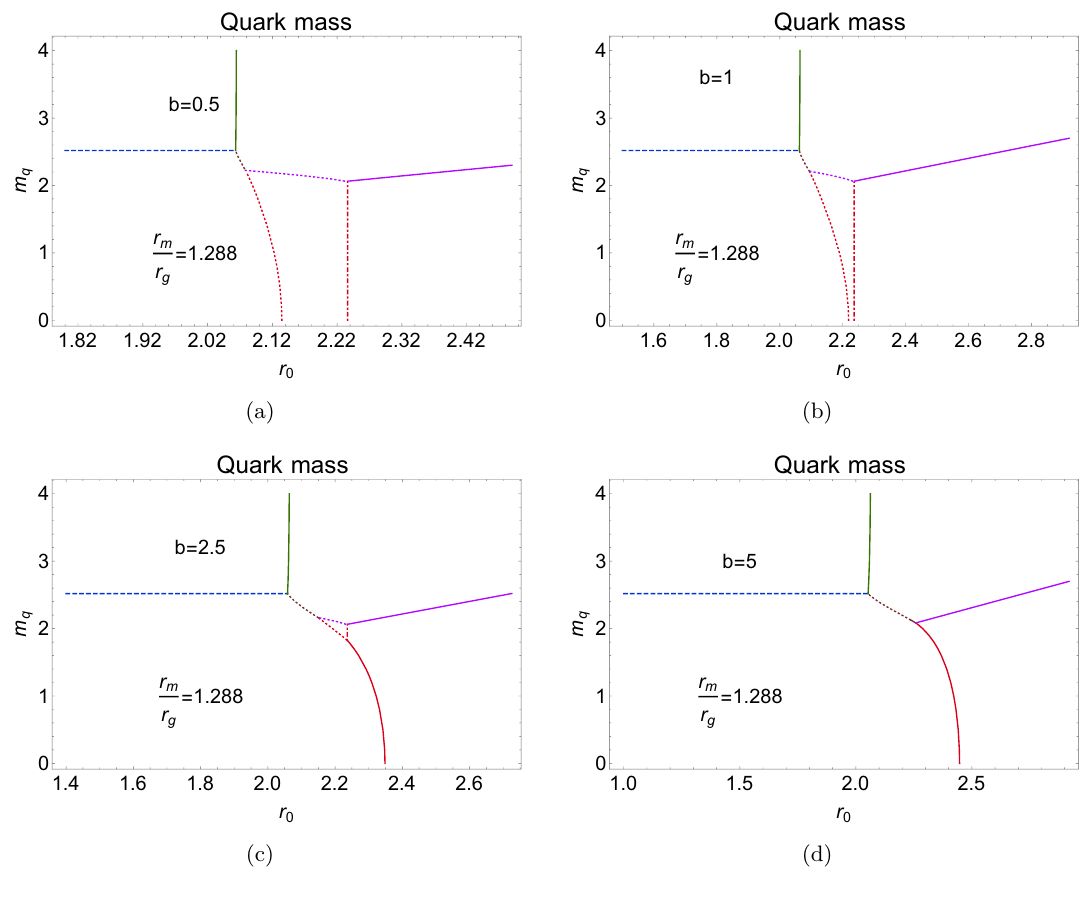
Figure 10 . Intermediate value r m